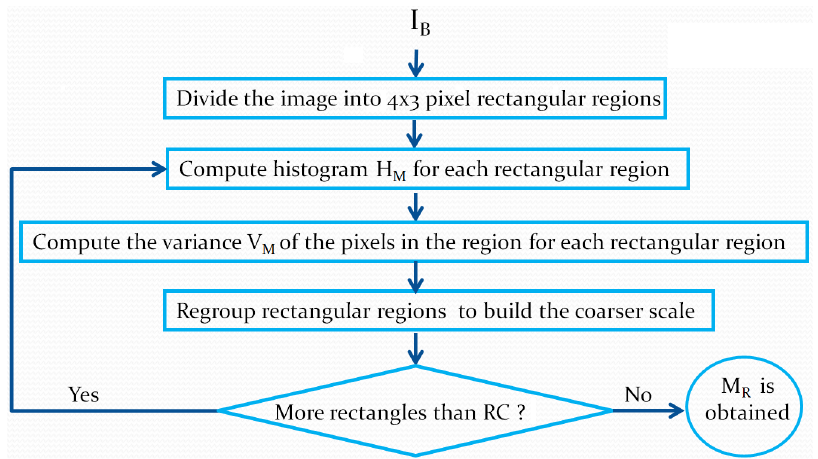
Figure 2. Steps of the background modeling